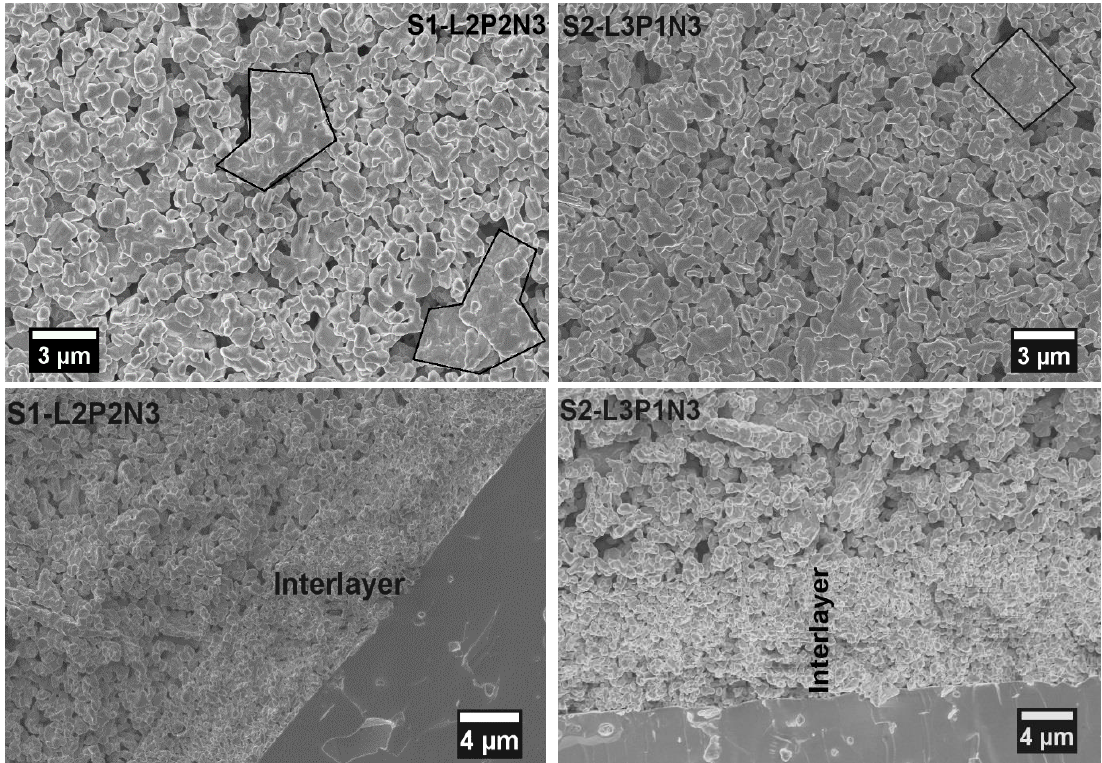
Figure 4. Post-test microstructural secondary electron SEM images showing the top view (TV) and cross-section (CS) view of the electrode in left: sample 1 (L2P2N3 electrode) and right: sample 2 (L3P1N3). Ball milling and triple roll milling improves the microstructure, but slight coarsening and sintering (highlighted areas) of the electrode in these samples can be observed. The use of an interlayer prepared from a LSGM electrolyte powder allows the interface to adhere